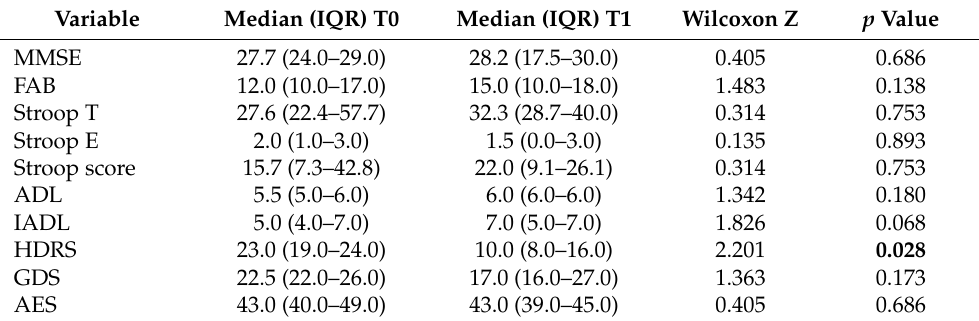
Table 2. Neuropsychological test scores of all participants at baseline (T0) and at follow-up (T1). Variable